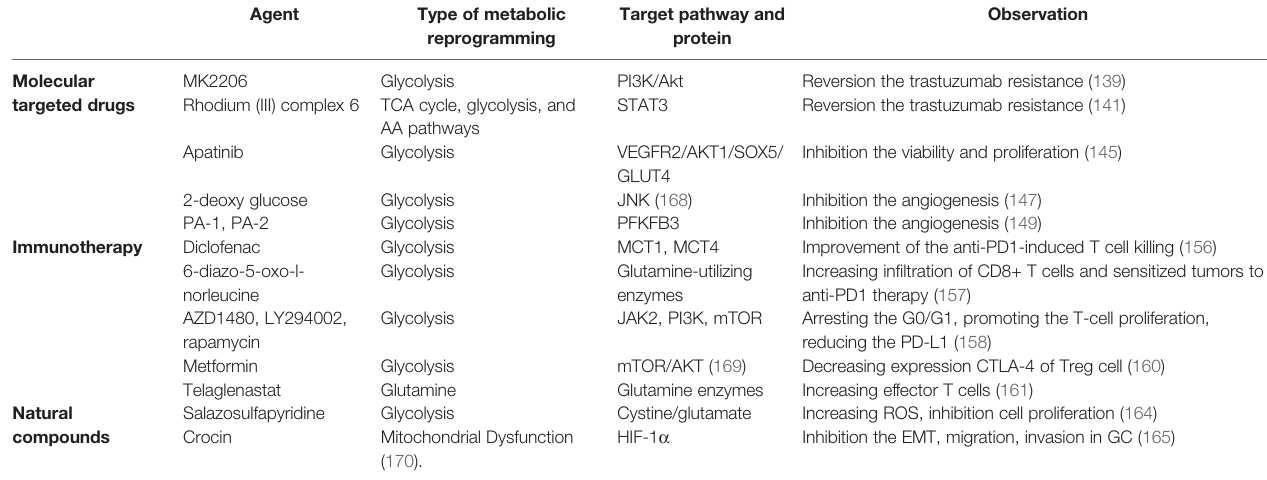
TABLE 2 | Metabolic reprogramming drugs in